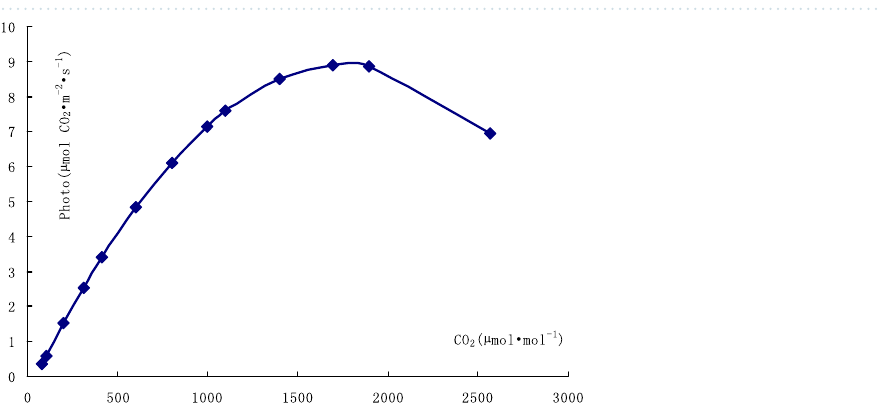
Figure 3. Fitted CO 2 response curve of Epimedium pubescens leaf photosynthesis with average